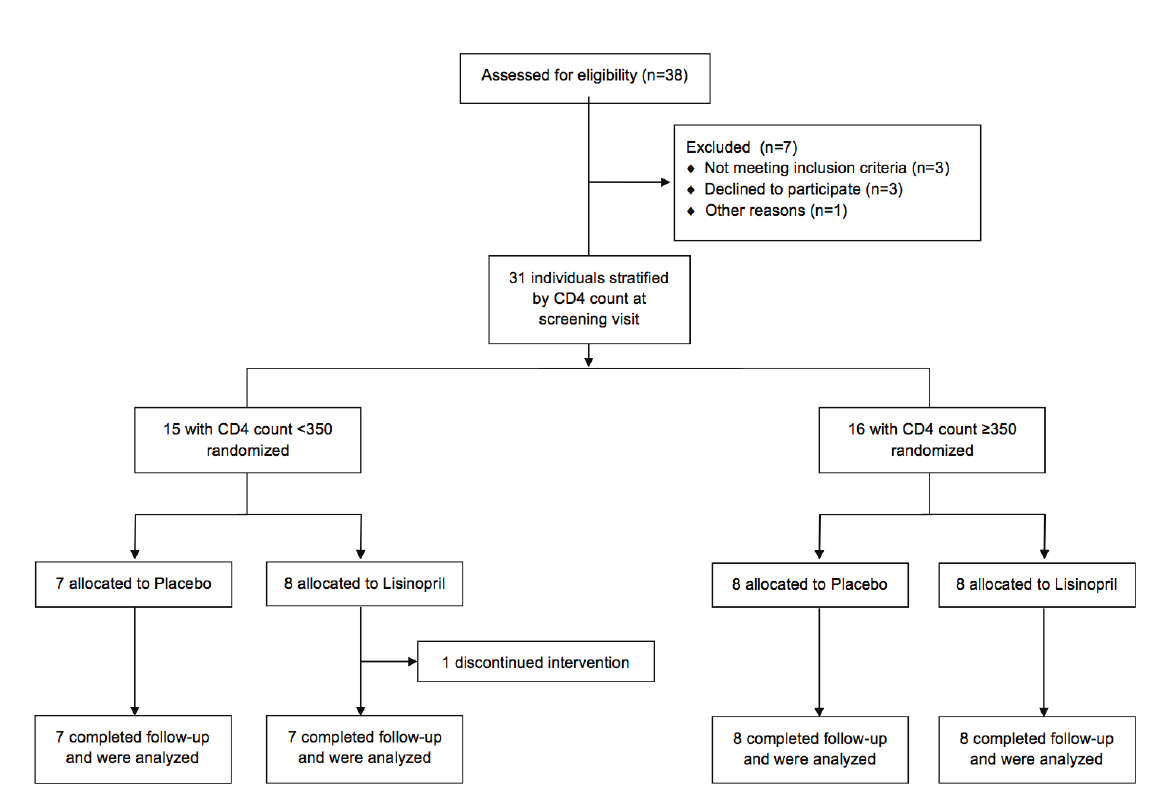
Supplementary Figure 1. Participant Flow Diagram - Participant Flow Diagram as per the Consolidated Standards of Reporting Trials (CONSORT)